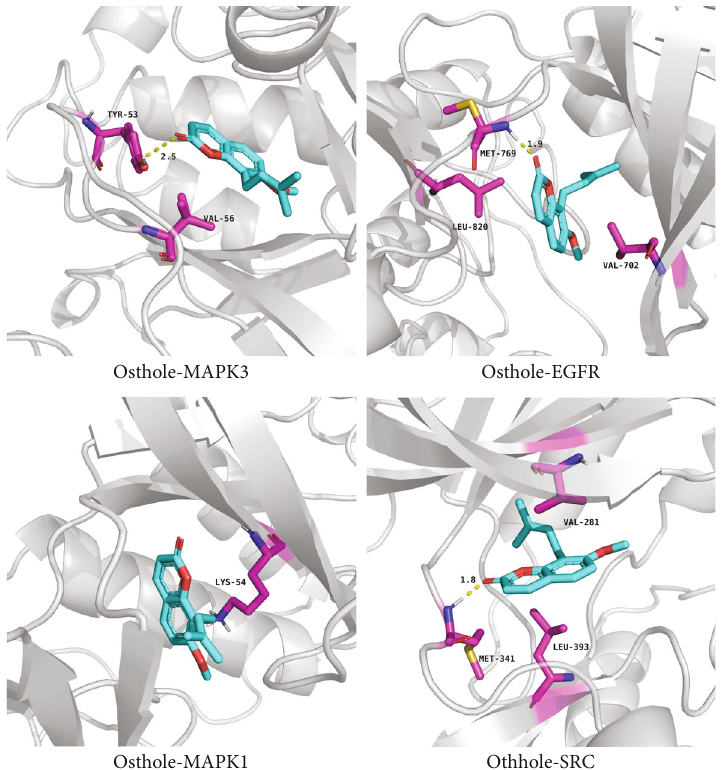
Figure 7: Three-dimensional graphs showing the binding of osthole and core target ( binding energy ≤ − 7kJ/mol